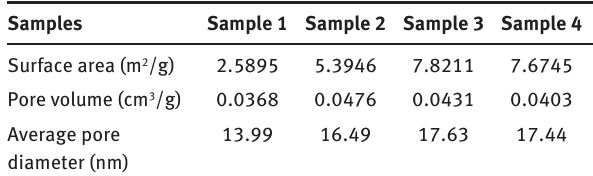
Table 3: Physical properties of different samples.